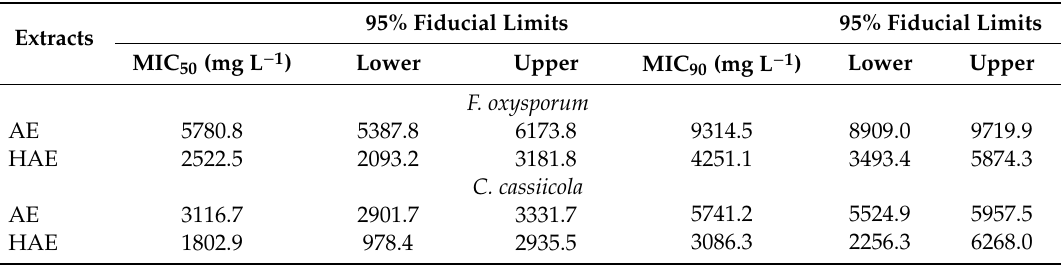
Figure 1. Mean antifungal activity (%) of R. microphylla (Rm) fruit extracts (AE, aqueous; and HAE, hydro-alcohol extracts) against C. cassiicola and F. oxysporum . Values at the same extract concentration with different letters ( a-b ) are significantly different ( p < 0.05). Table 2. Minimum inhibitory concentrations (MICs) of R. microphylla (Rm) fruit extracts that causes a 50% and 90% reduction in the growth of F. oxysporum and C. cassiicola